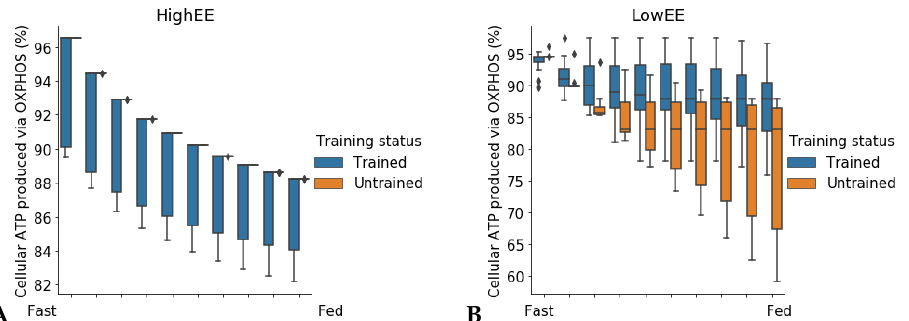
Figure 6. Increased utilization of oxidative phosphorylation (OXPHOS) in trained models in response to low energy demands. Percentage of total cellular ATP produced was measured as flux through the adenine nucleotide translocator (ANT) reaction (reaction ID: ATPtm). Twenty-one models were included in the analysis (N trained = 12, N untrained = 9). ( A ) High energy expenditure. ( B ) Low energy expenditure. In low EE conditions, trained models produce a higher percentage of total ATP from OXPHOS than untrained ones. Untrained models show a larger variance in the percentage of total ATP obtained from OXPHOS than untrained